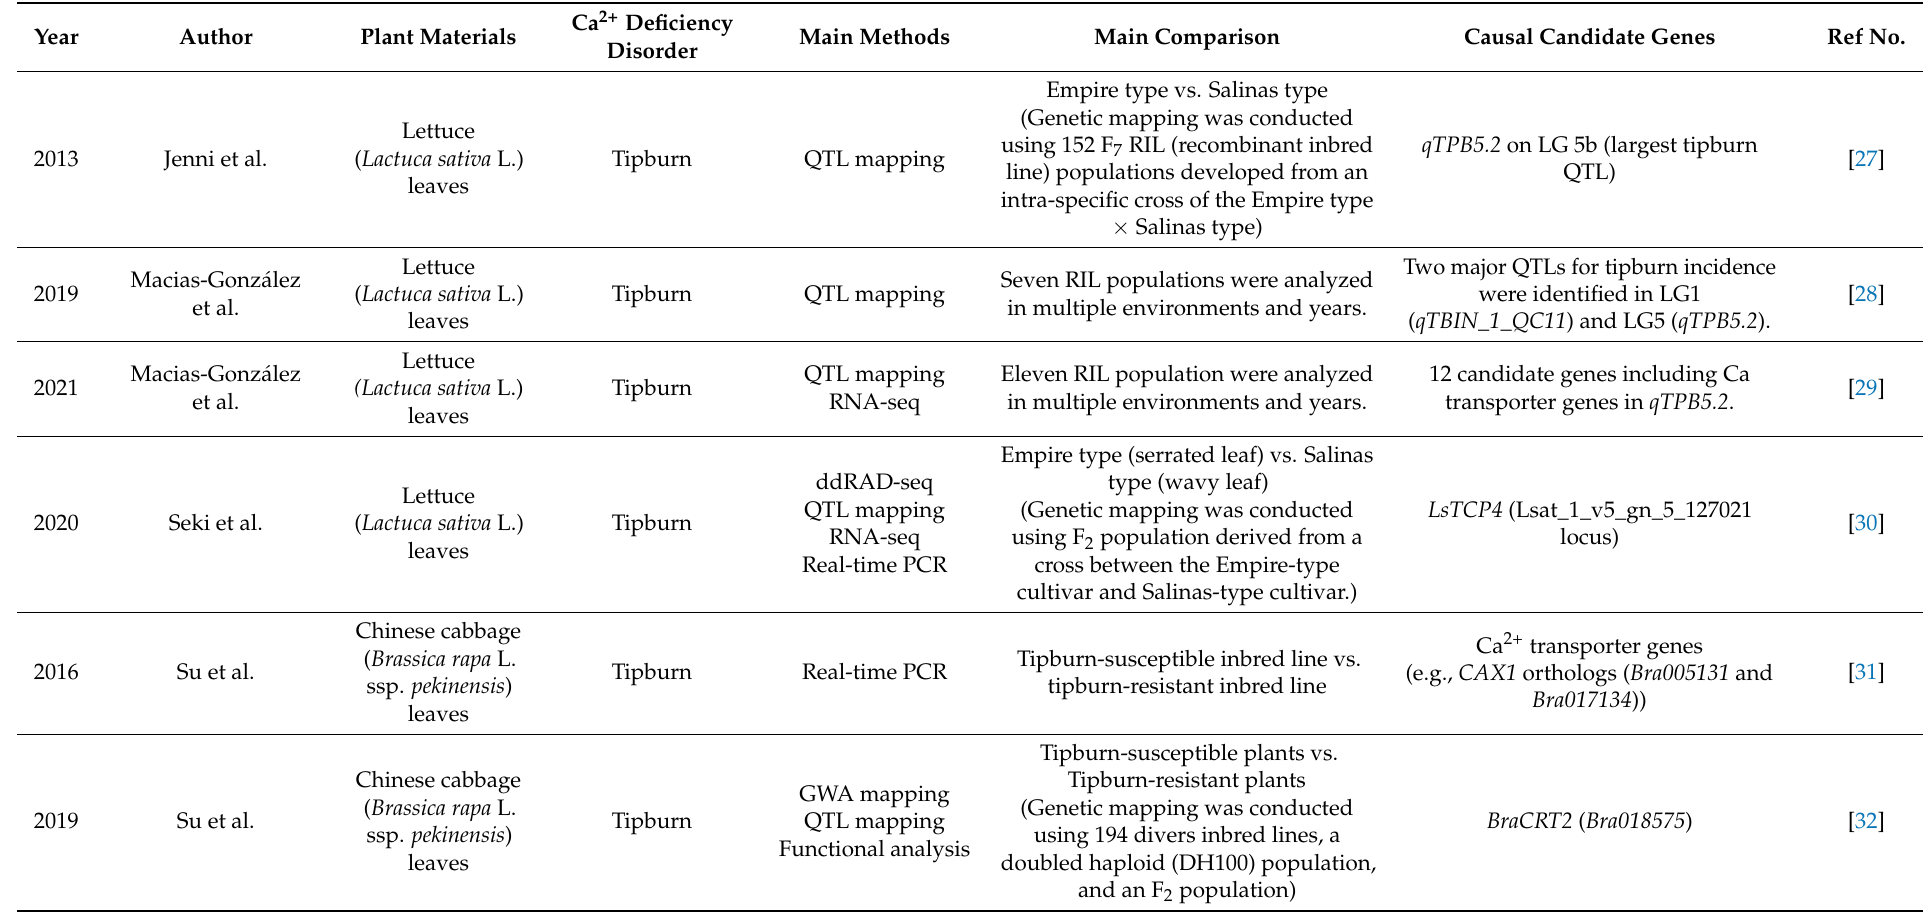
Table 1. Overview of the studies using genetic analysis to identify the causative genes of Ca 2+ deficiency disorders (tipburn and BER) obtained via Search